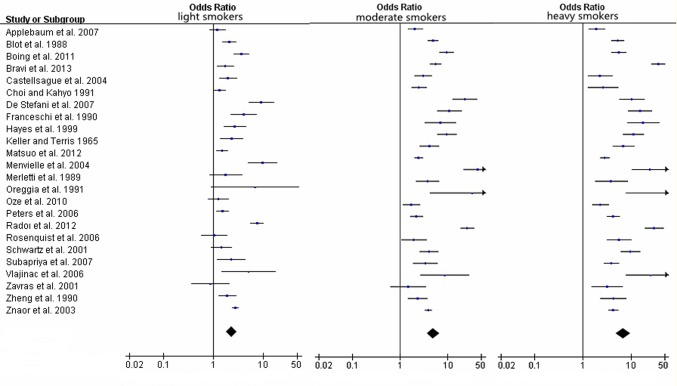
Forest plots for pooled Odds ratios (ORs) and the corresponding 95% confidence intervals (CIs) of HNC cancer risks for light, moderate and heavy smokers.